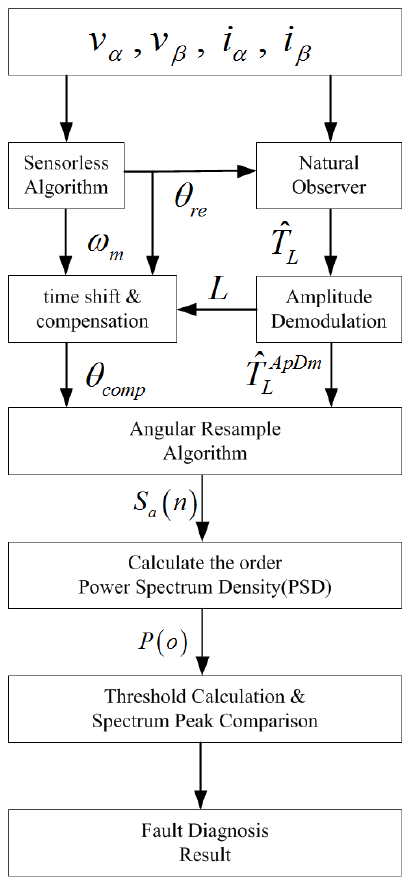
Figure 1. Implementation of the proposed